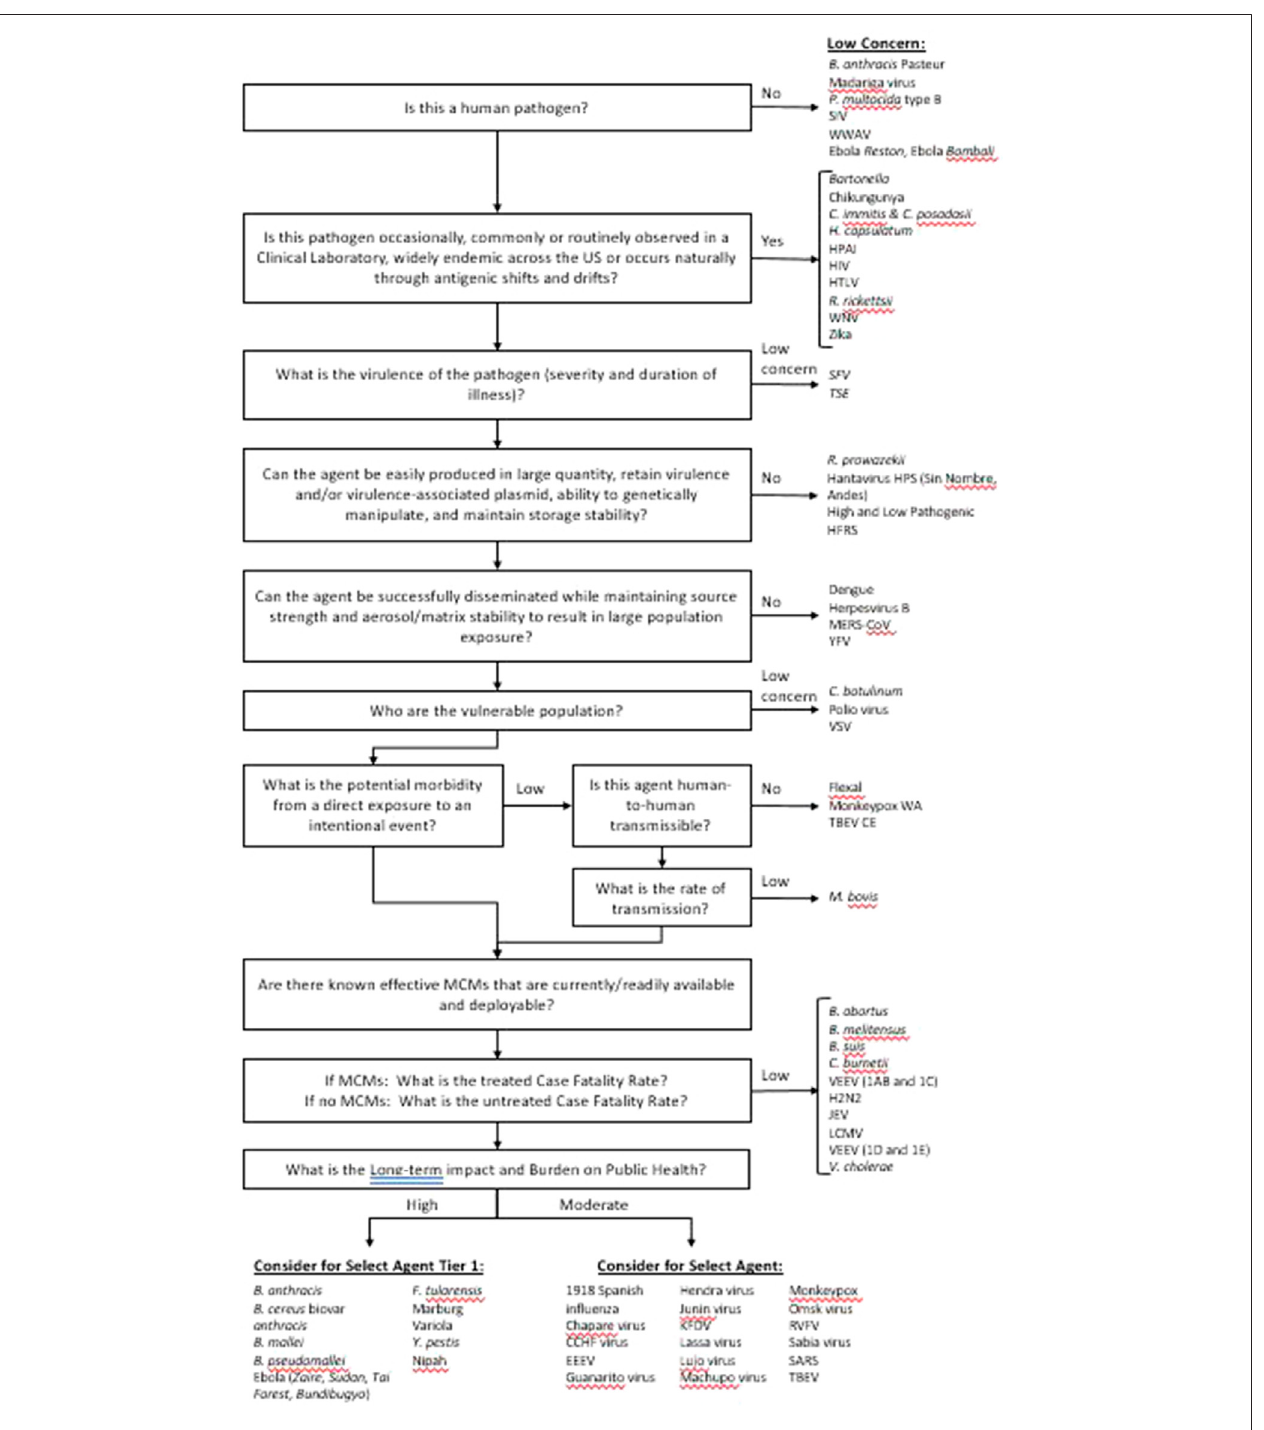
FIGURE 2 | Decision Support Framework for assignments of select and non-select